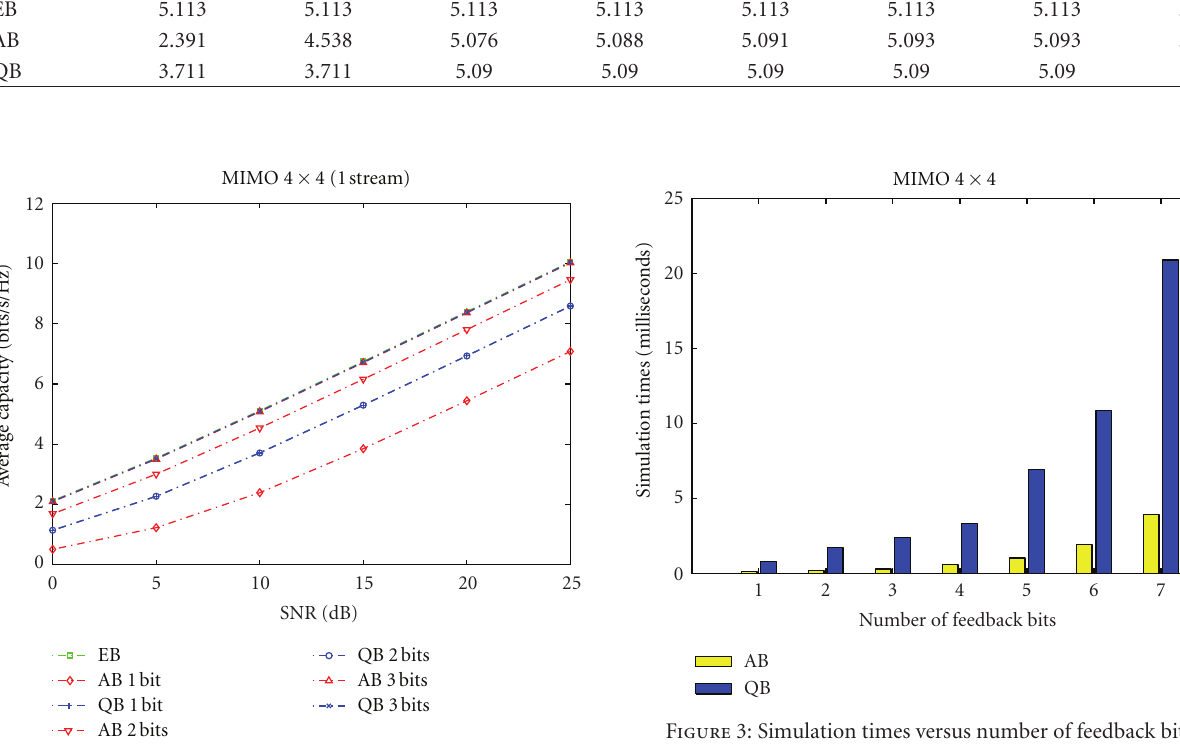
Figure 2: Capacity versus SNR.